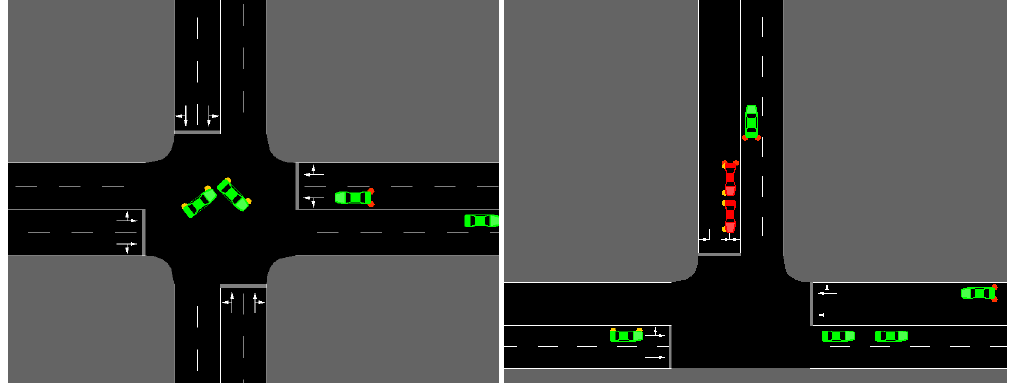
Figure 2. Cars approaching